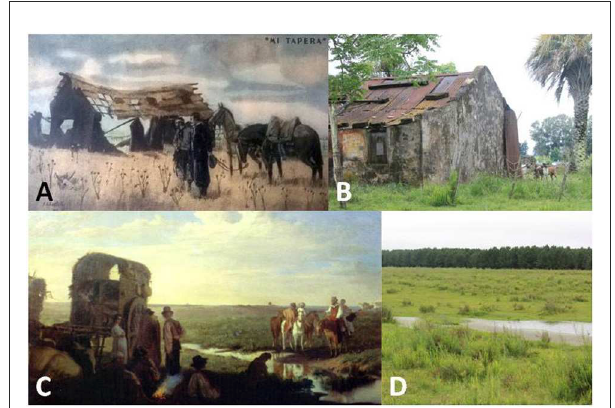
FIGURE1 The cultural landscape of the Patria Gaucha is shaped by the European colonialization: “Parecería que la tierra uruguaya fuera una región formada por trozos de diversos países europeos porque aquí tanto el Español como el Italiano, el Francés como el Inglés, el Alemán como el Suizo, se consideran como su propia patria y la aman cual al propio suelo” [ a english: It seems that the Uruguayan land is formed by pieces of different European countries, here the Spanish and the Italian, the French and the English, the German and the Swiss consider it as their own homeland and love it as their own soil] (Maeso, C. Tierra de promisión 1910:14; cited after Caetano, 2010). Historical narratives, images and field names reflect physical, socio-cultural and individual dimensions of landscape. (A) Mi Tapera (after the popular song of Elias Regules “Entre los pastos tirada, como una prenda perdida, en el silencio escondida, como caricia robada, completamente rodeada por el cardo y la flechilla, que, como larga golilla, van bajando a la ladera, está una triste tapera,